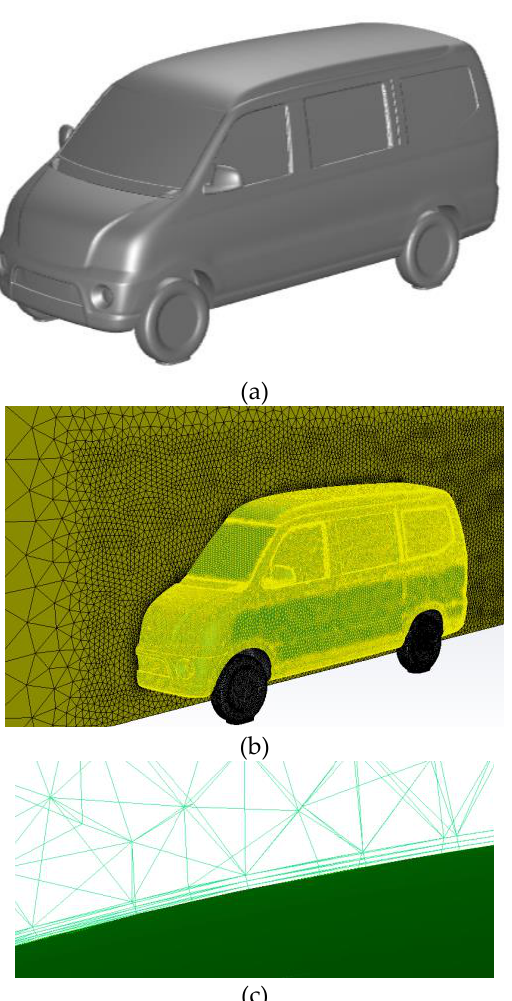
Figure 1. ( a ) CAD model of the original minivan model. ( b ) Surface mesh of the original minivan model. ( c ) Prism mesh.